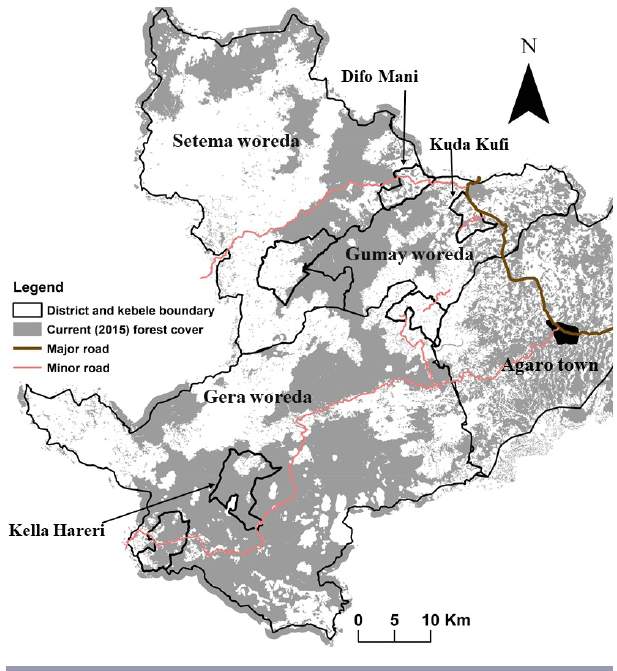
Fig. 1 . Map of the study area showing the three woredas (districts), the three kebeles (municipalities), forest cover, and access to road infrastructure. Kella Hareri is in the coffee altitude with high forest cover whereas Kuda Kufi and Difo Mani have little forest cover but better access to road